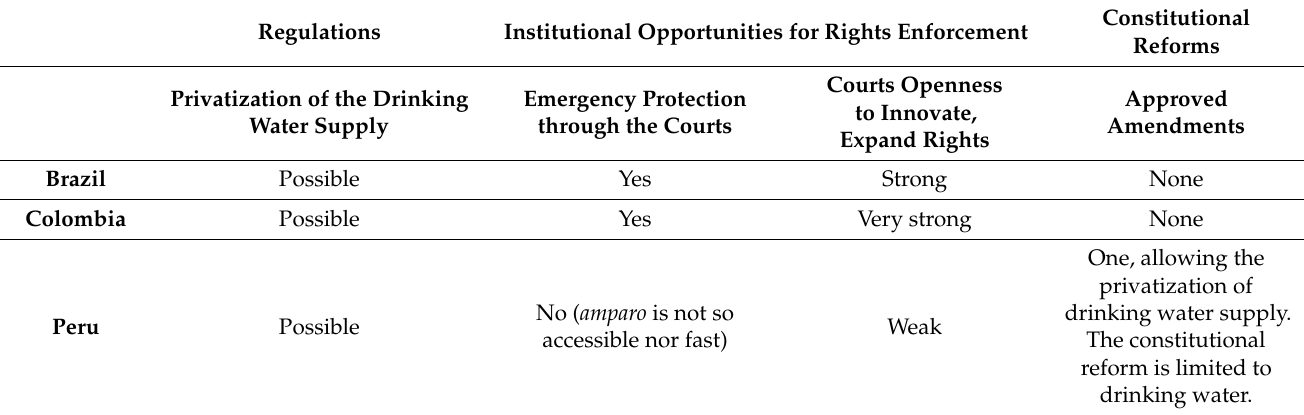
Table 3. Summary of the legal institutional settings for the enforcement of the right to water.